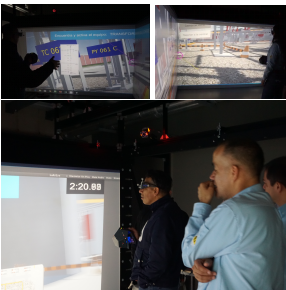
Figure 8. Technicians who knew the process and who were familiar with the mission that was being carried out, playing and evaluating the training serious